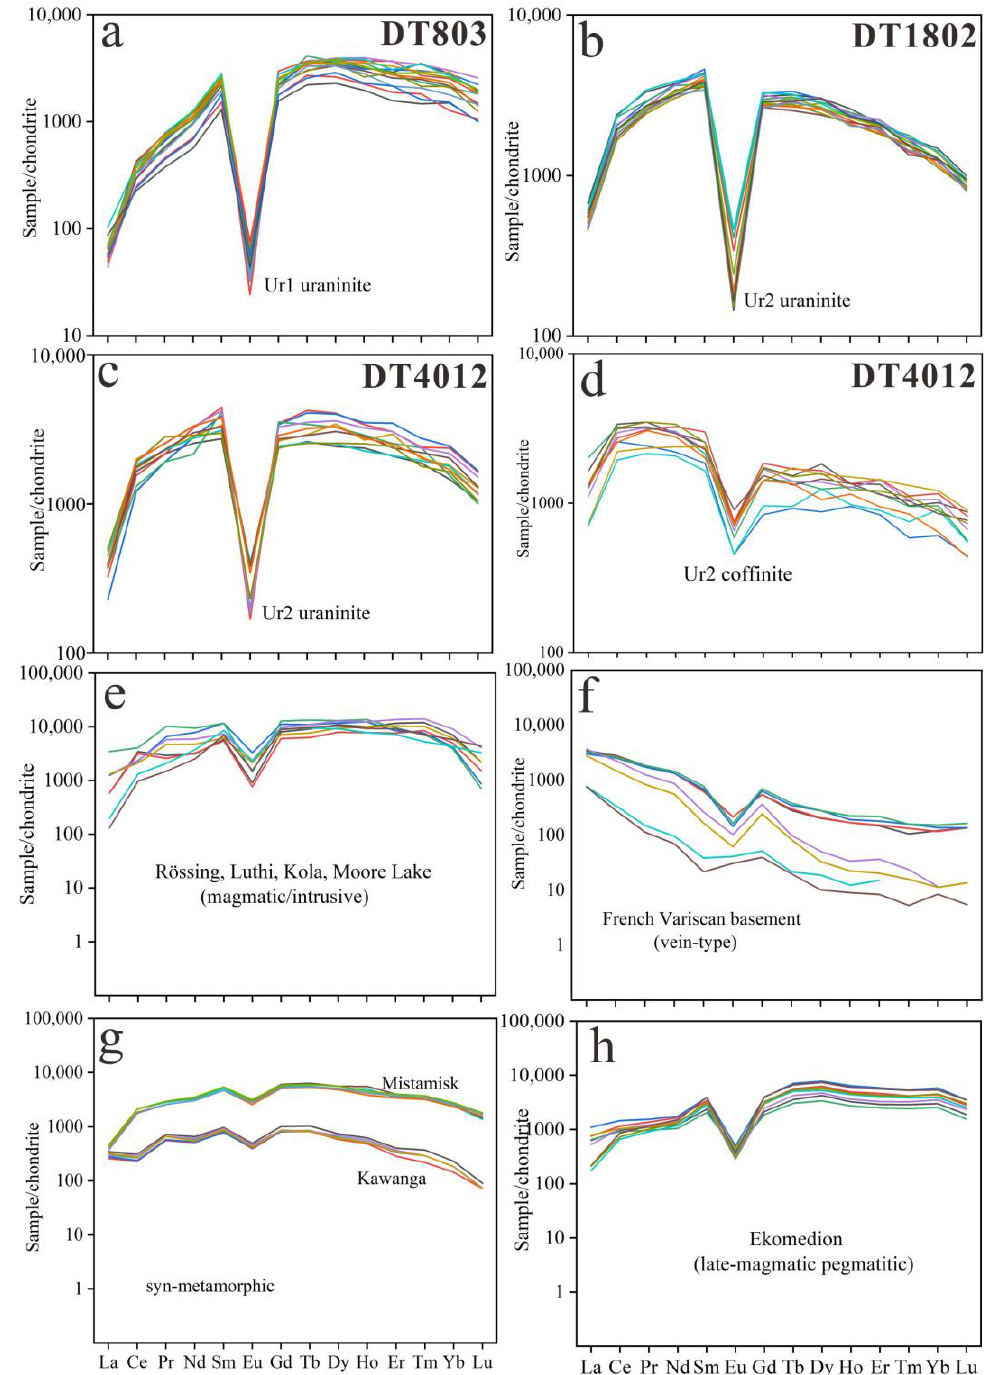
Figure 10. Chondrite-normalized REE patterns of the uraninite and coffinite from the Datian uranium deposit and various hydrothermal and magmatic deposits around the world; ( a – c ) REE patterns of the uraninite and ( d ) REE patterns of the coffinite from this study; ( e – g ) data from Mercadier et al. [42]; ( h ) data from Frimmel et al. [43]; LREEs are from La to Eu and HREEs are from Gd to Lu; normalization values from Anders and Grevesse [44].